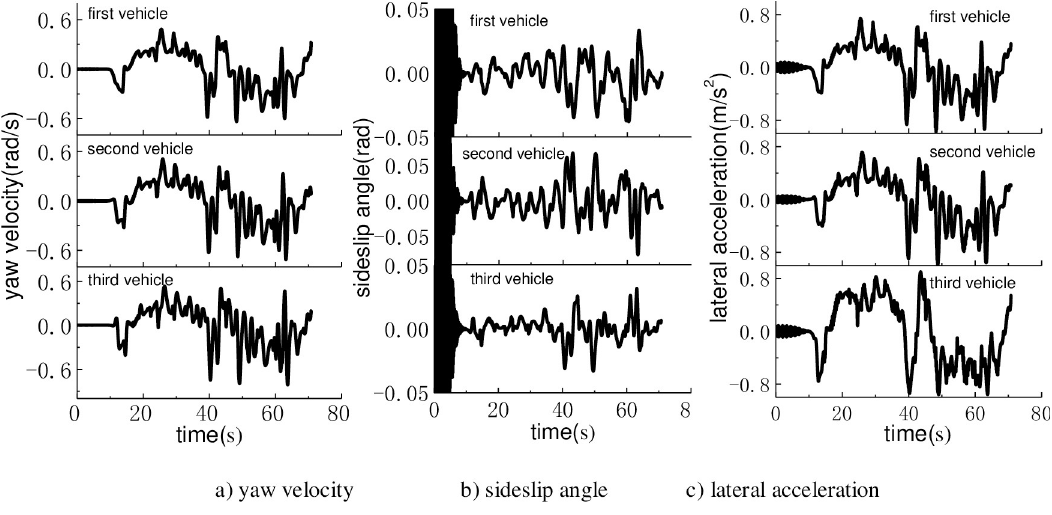
Fig 10. The dynamics performances in the tracking